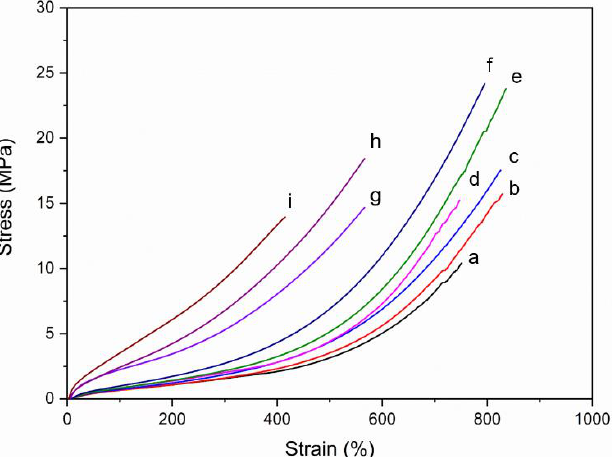
Figure 14. Stress-strain curve of the ( a ) DPNR; ( b ) DPNR-10Si; ( c ) DPNR-20Si; ( d ) P10-DPNR; ( e ) P10-DPNR-10Si; ( f ) P10-DPNR-20Si; ( g ) P30-DPNR; ( h ) P30-DPNR-10Si; ( i ) P30-DPNR-20Si composites.